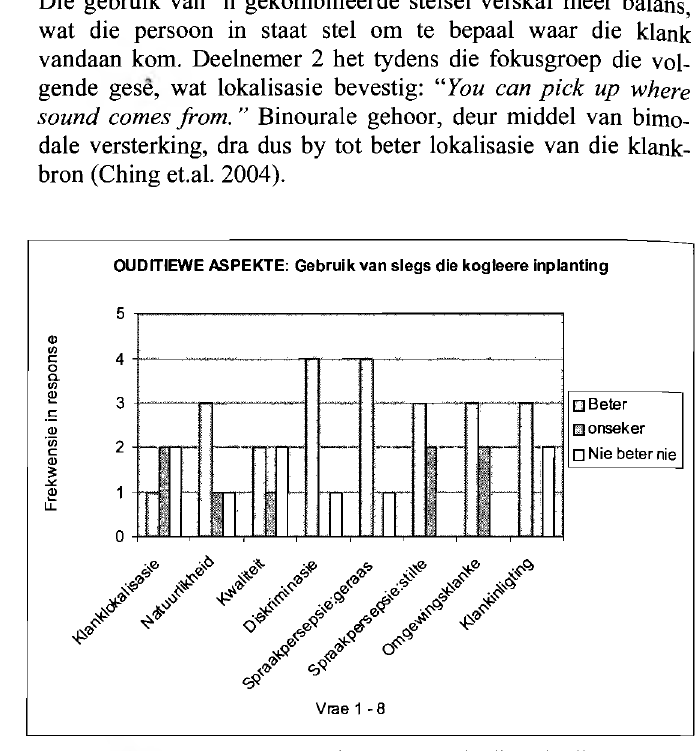
Figuur la: Deelnemers se ervarings aangaande die gebruik van slegs die kogleere inplanting in terme van ouditiewe fiinksionering.